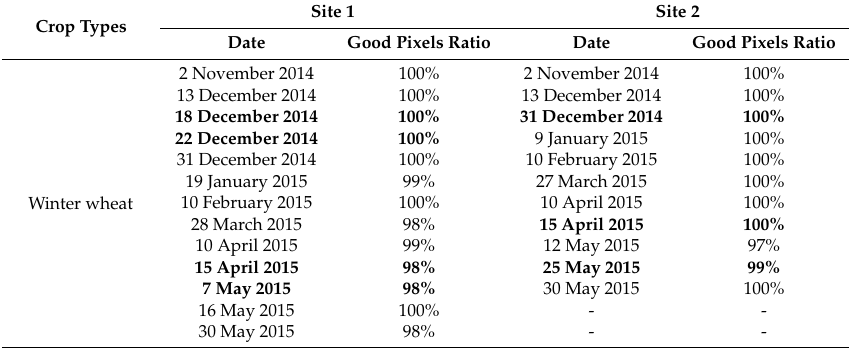
Table 2. The Project for On-Board Autonomy-Vegetation (PROBA-V) 100-m S1 product used in the